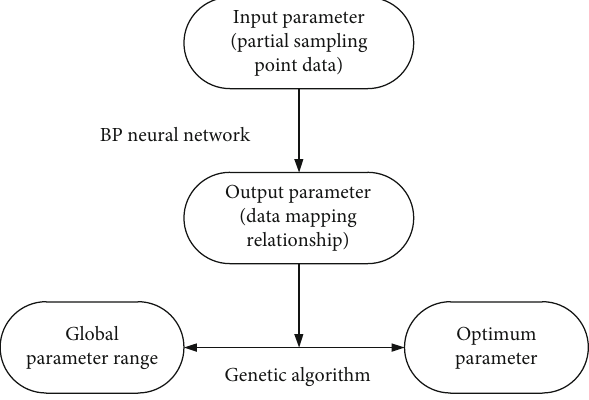
Figure 8: Schematic diagram of BP neural networks and genetic